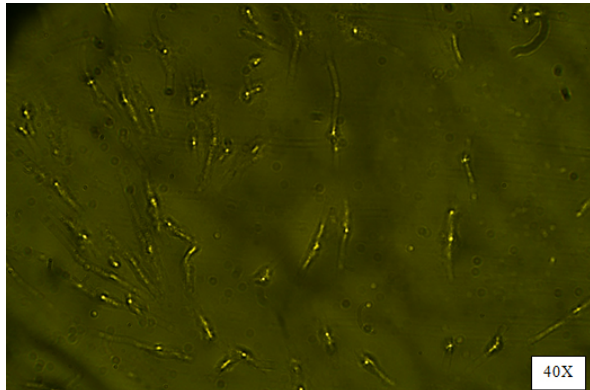
Fig. 5. Immunofluorescence staining of α -actinin in day 13 after treatment with the small molecules and phytoestrogen .